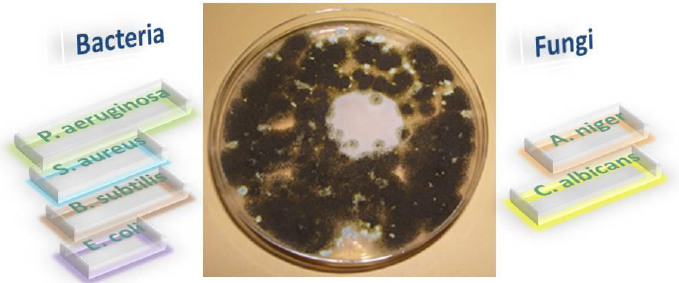
Figure 3. Biological activities of the studied compounds.